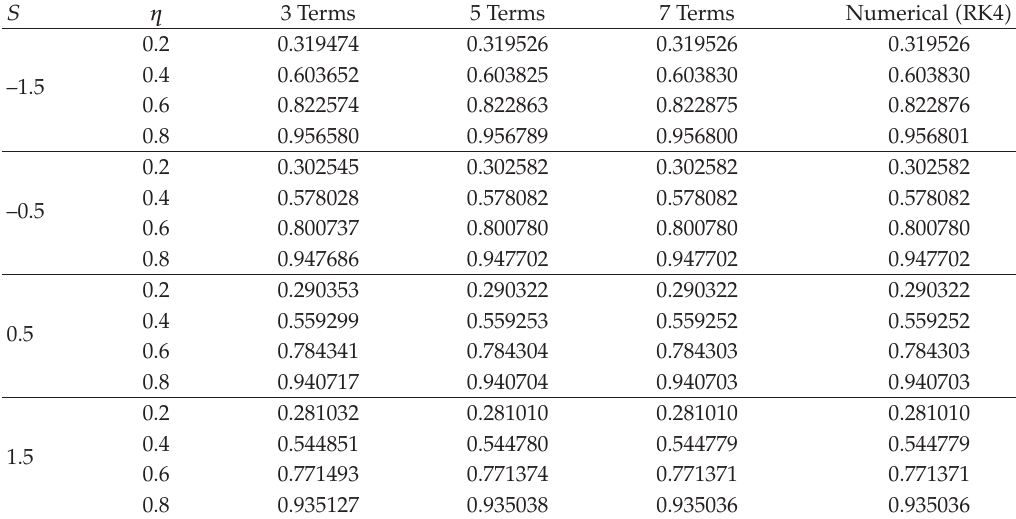
Table 1: The analytic results of f (cid:3) η (cid:4) at di ff erent terms of approximation compared with the numerical results (cid:3) RK4 (cid:4) for the axisymmetric